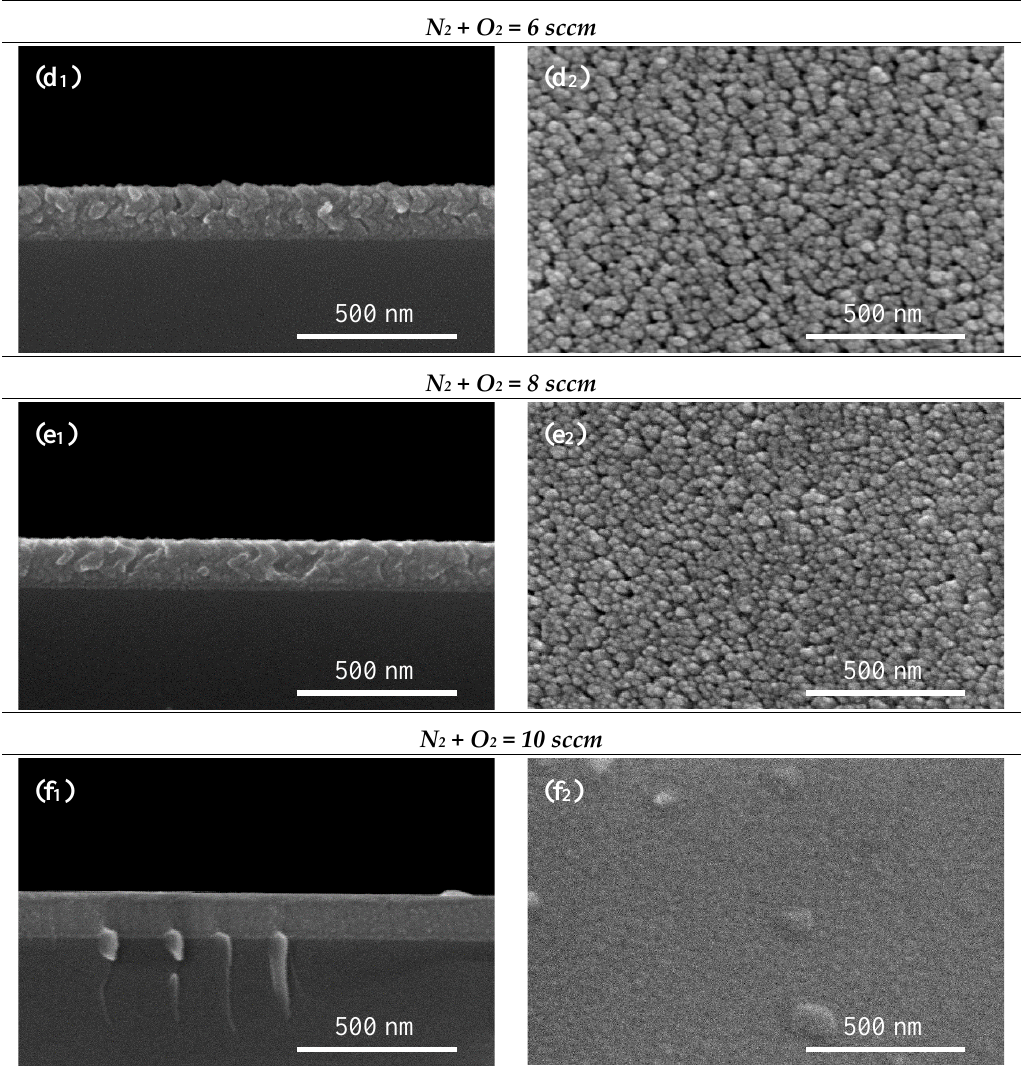
Figure 4. SEM of the fractured cross-section views ( a 1 – f 1 ) and surface ( a 2 –f 2 ) of the TiCu(O,N) thin films deposited on silicon sputtered with different concentrations of N 2 + O 2 . ( a 1 –a 2 ) (N 2 + O 2 ) flow = 0 sccm, ( b 1 –b 2 ) (N 2 + O 2 ) flow = 2 sccm, ( c 1 –c 2 ) (N 2 + O 2 ) flow = 4 sccm, ( d 1 –d 2 ) (N 2 + O 2 ) flow = 6 sccm, ( e 1 –e 2 ) (N 2 + O 2 ) flow = 8 sccm, ( f 1 –f 2 ) (N 2 + O 2 ) flow = 10 sccm.